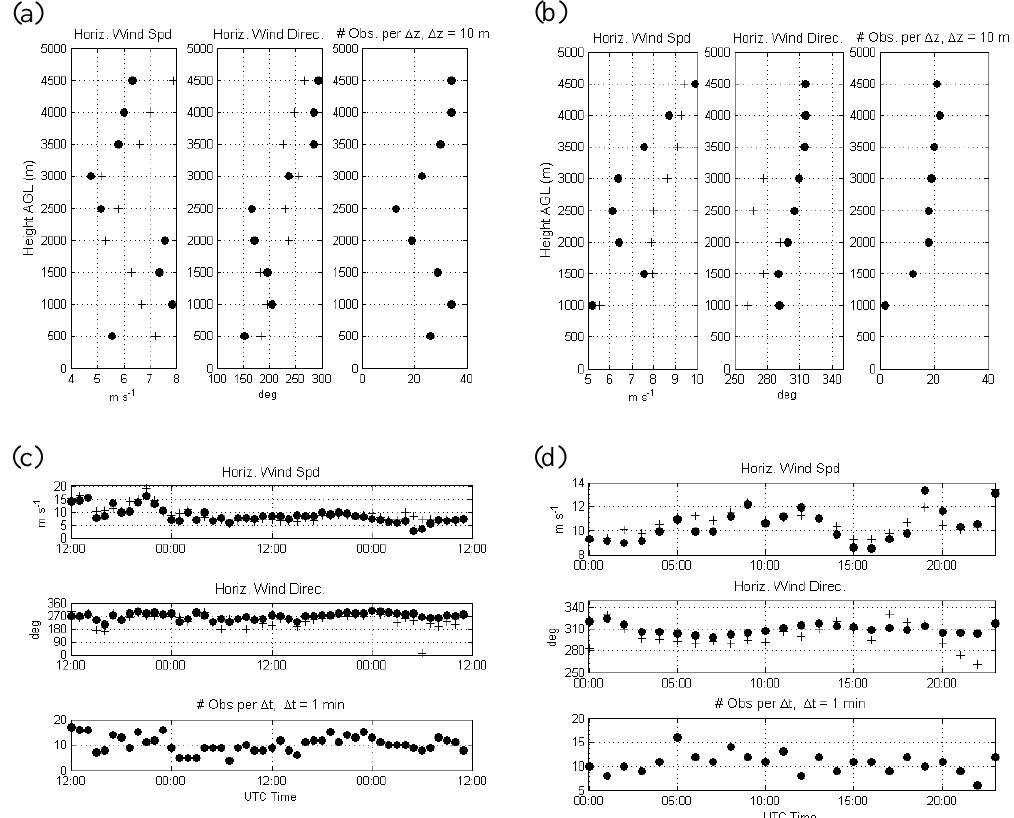
Fig. 6. Model verification versus height (a, b) and time (c, d) using VHF wind profiler measurements of horizontal wind speed and direction. The wind profiler is located at Harrow, ON (42 ◦ 42 0 N83 ◦ 28 0 W). Model estimates are interpolated to observations which are hourly mean values for the 500m bin up to the height specified. Each row shows the (bin-averaged) observed values (+) and model estimates (circles). Data from Period 1 (a, c) and Period 2 (b, d) are shown. The number of observations contributing to each bin is illustrated in the third column (row) of the top (bottom) row